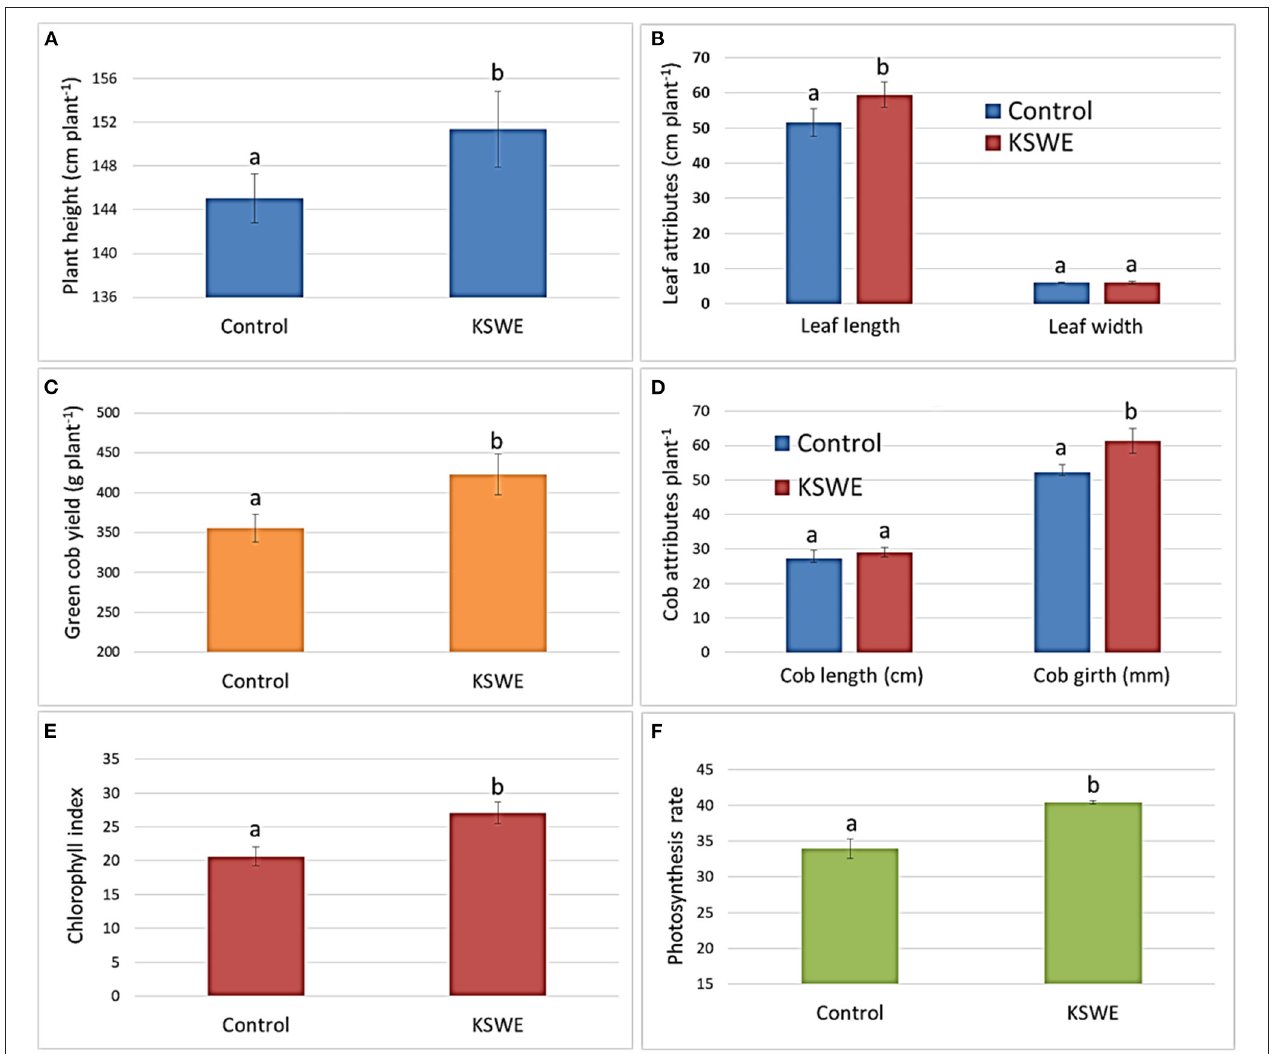
FIGURE 3 | (A–F) Growth, yield, and photosynthetic attributes of KSWE and control plants. Values represented are mean of six replicates except photosynthetic rate, which is the mean of three replicates. Bars followed by different alphabets are significantly different using t -test ( p < 0.05).